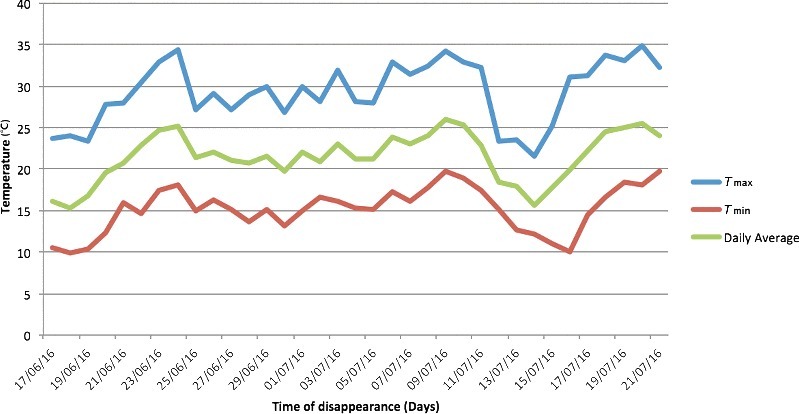
Temperatures recorded by the weather station (1.6 km far from the death scene) for the 34 days before the discovery of the body (Tmax: 34.9 °C; Tmin: 9.9 °C) in Case 1.